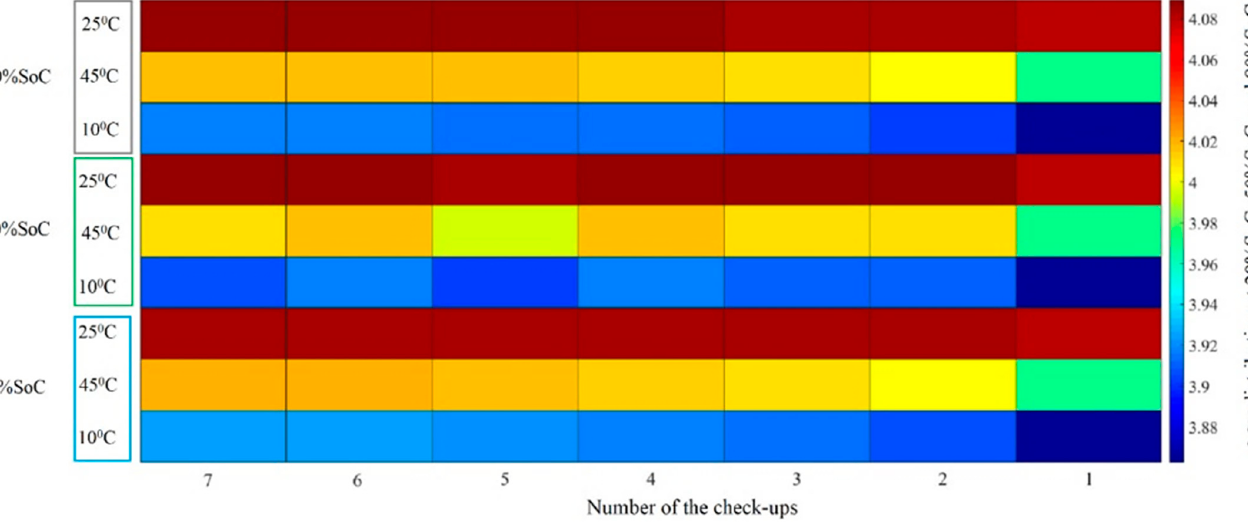
Figure 9. Comparison of the OCV pattern at 25 °C under C/2 charge and C/5 discharge test conditions.